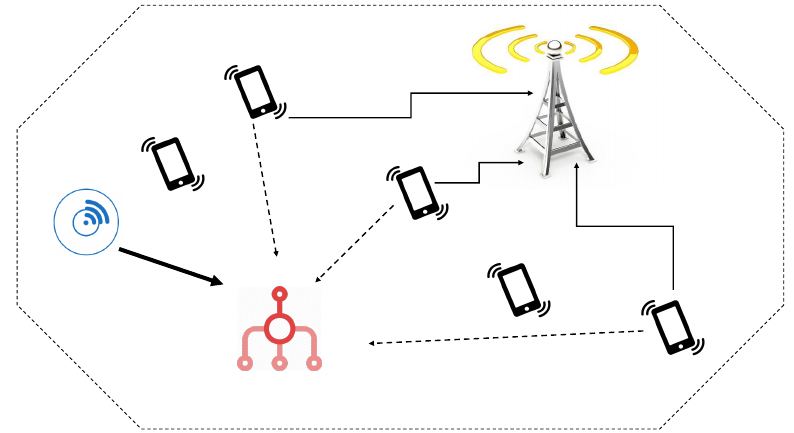
Figure 1. An illustration of the dynamic spectrum access scenario, where licensed and unlicensed users share the up-link channel. The unlicensed transmitter is depicted by the smart meter, the aggregator (unlicensed receiver) by the red aggregator, the handsets are the mobile licensed nodes (interferers to the aggregator) and the big antenna is the cellular base-station. As the smart meter uses directional antennas with limited transmit power (bold arrow), its interference towards the base-station can be ignored. The thin black arrows represent the licensed nodes’ desired signal, while the dotted ones represent their interference towards the